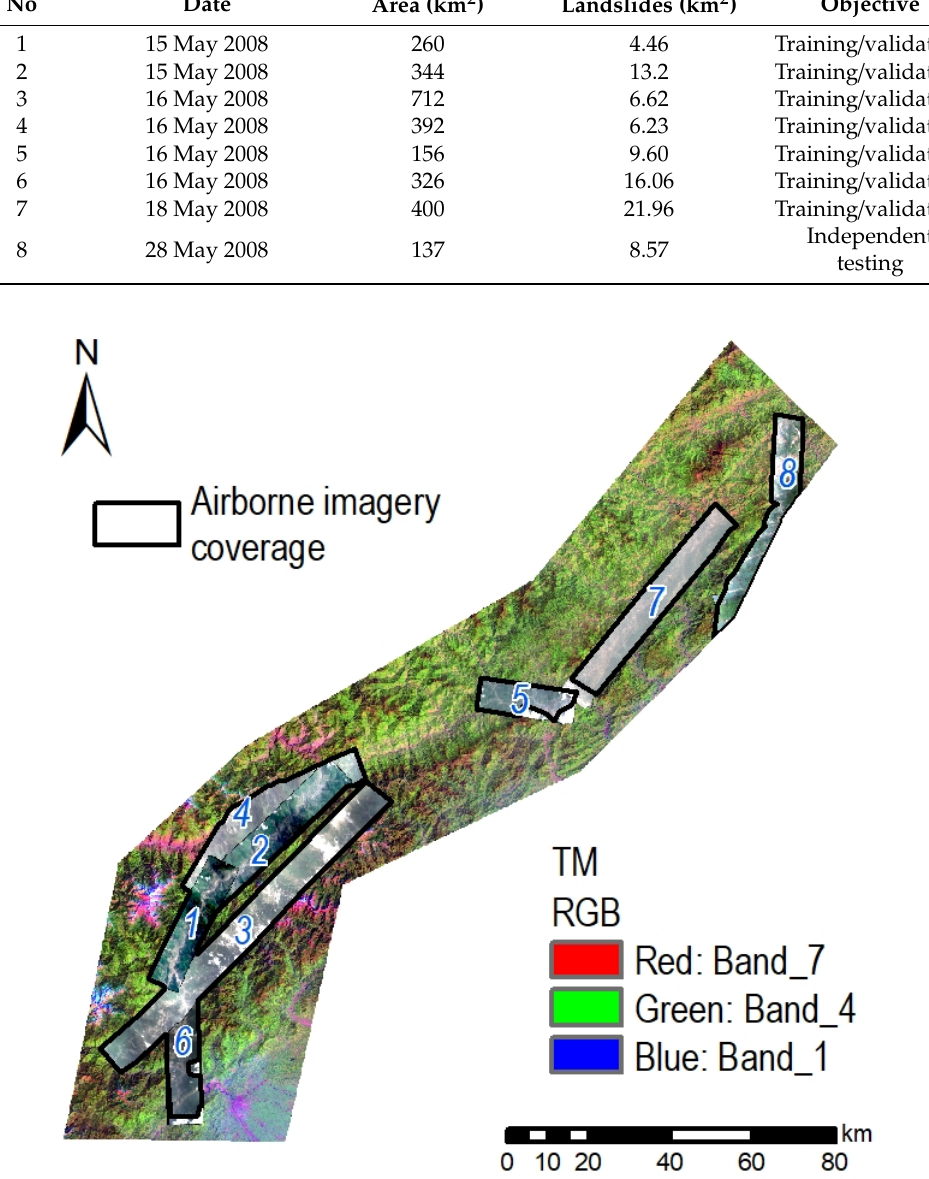
Figure 2. Pre-earthquake Thematic Mapper (TM) color composite and post-earthquake airborne imagery coverage. The blue color numbers show the number (No) of airborne images as Table 1. No. 1 to 7 airborne images were used as model area for developing the U-net like model while No. 8 imagery was used for independent testing.